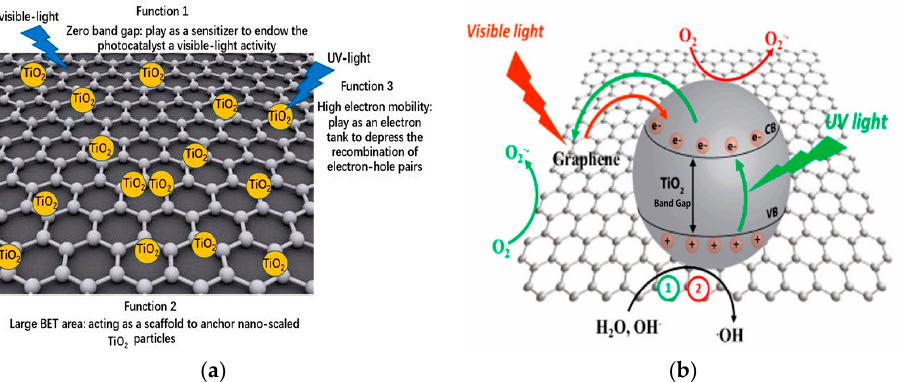
Figure 6. Schematics displaying the ( a ) roles of graphene layers of graphene/TiO 2 composite in photocatalysis, and ( b ) charge transfer mechanism under ultraviolet or visible light irradiation. Reproduced with permission from [145,153], respectively. Copyright MDPI, 2018 and 2017.